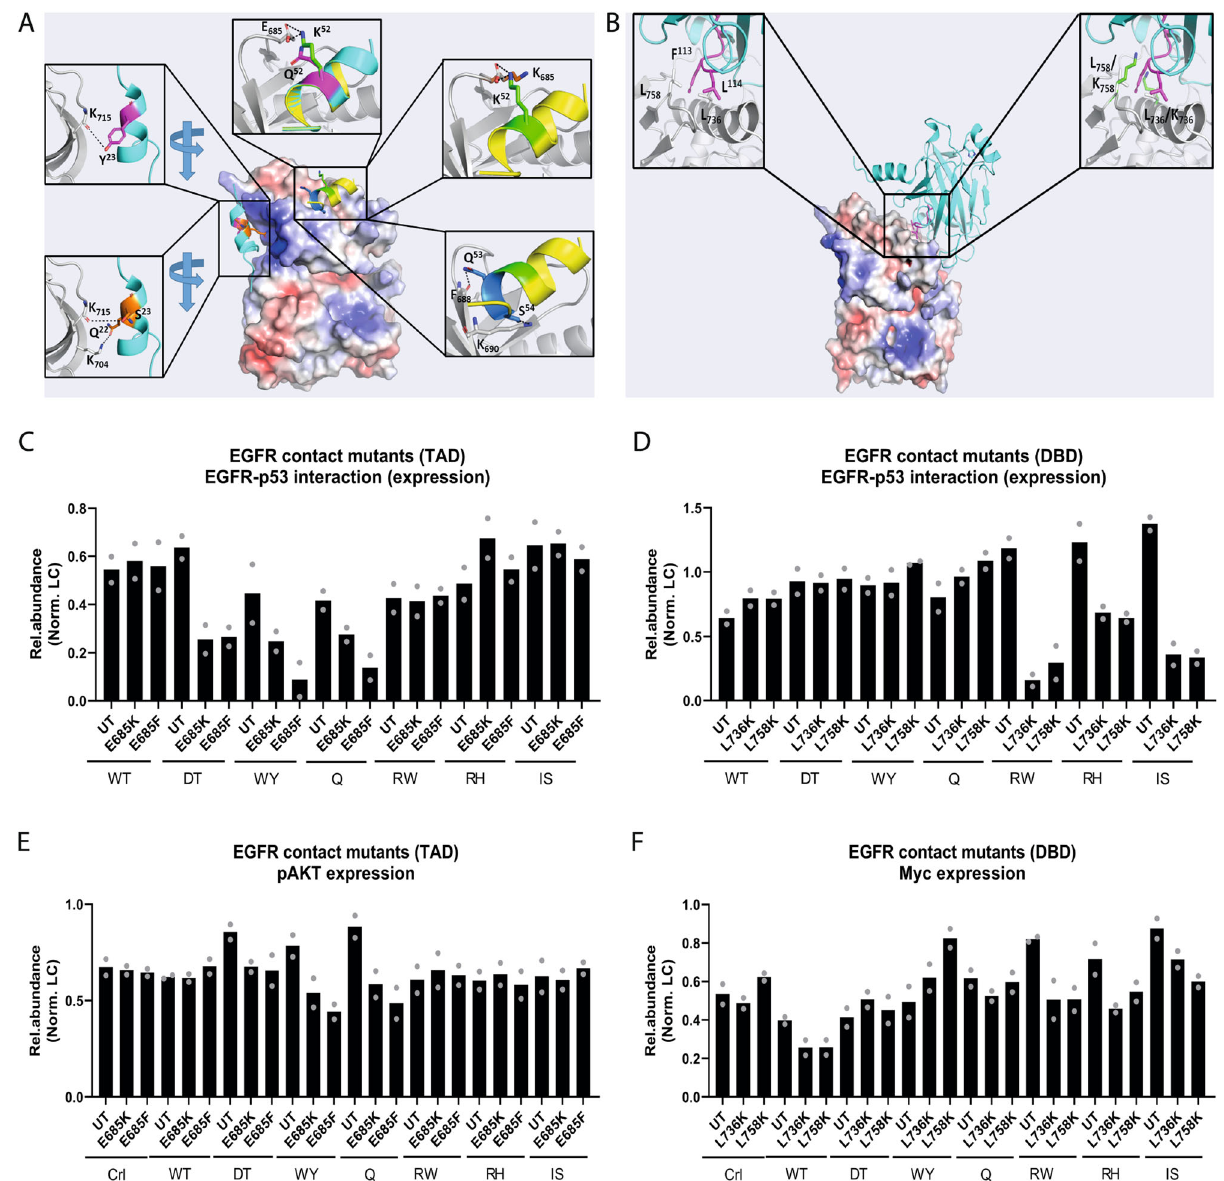
Fig.5|TADandDBDmutantsinteractwithEGFRatspeci fi csites.A Structureof the modeled EGFR-p53TAD mutant complexes. EGFR is shown with its surface colored by the electrostatic potential (with red to blue colors corresponding to potentials of − 5kcal/mol to + 5kcal/mol) and the p53 TAD peptides shown as cartoon (TAD1: Cyan, TAD2: yellow). Top middle: zoom in view of the EGFR- p53TAD2 complex, with EGFRand p53TAD2 shown as cartoon, with residues E685 from EGFRand K52/Q52 from TAD2 shown assticks;the likely salt bridge between E685 and K52 ishighlighted in dashed lines (black).Top right: zoom in view ofthe EGFR-p53TAD2 complex, with EGFR and p53TAD2 shown as cartoon and the sug- gested mutation E685K in EGFR and Q52K in TAD2 shown as sticks. Bottom right: view of the EGFR-p53TAD complex highlighting the interactions (black dashed lines) between residue F688 from EGFR with residue Q53 from TAD2 and K690 from EGFR with residue S54 from TAD2. Top left: zoom in view of the EGFR- p53TAD1 complex with residue K715 from EGFR and W23Y from Tad1 shown as sticks; the likely hydrogen bond interaction between K715-Y23 is highlighted in dashed lines (black). Bottom left: zoom in view of the EGFR-p53TAD1 complex